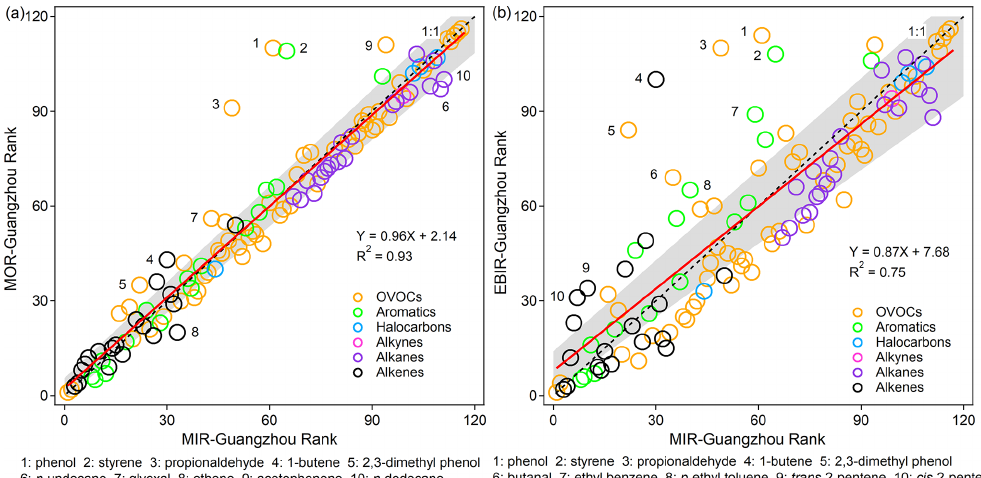
Figure 3. Correlations between the emission-based IR ranks for 116 VOC species under MIR scenarios vs. (a) MOR scenarios and (b) EBIR scenarios. The top 10 VOC species with a relatively large rank change are marked with numbers (shown below the individual panels). The IR scales for VOCs are ranked in descending order – from the highest IR value (rank = 1) to the lowest IR value (rank = 116). The gray shaded areas indicate the least square linear regression line with ± 95% confidence, and the black dashed line represents the 1 : 1 line.